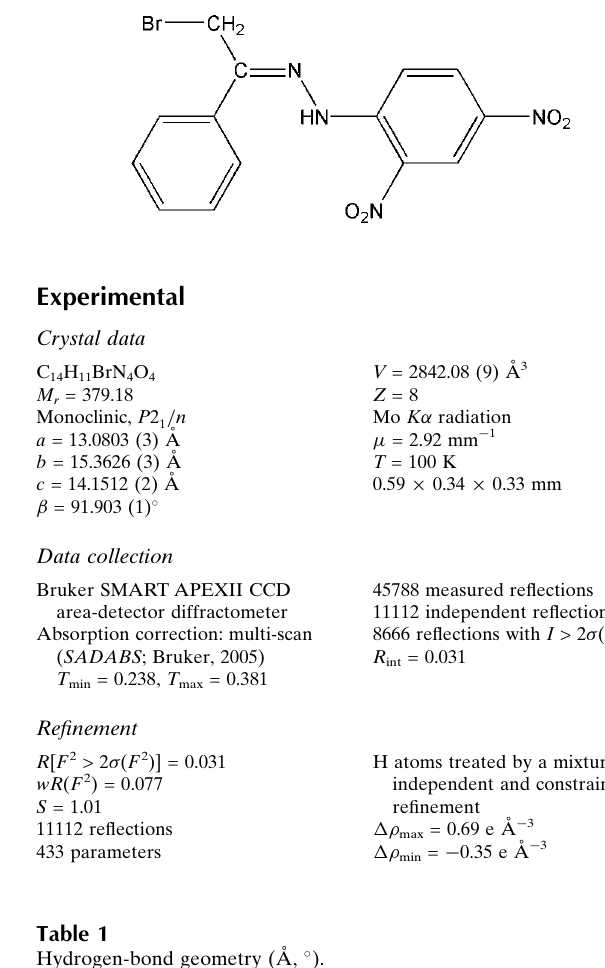
Hydrogen-bond geometry (A˚ , (cid:3) ). D —H (cid:2)(cid:2)(cid:2) A D